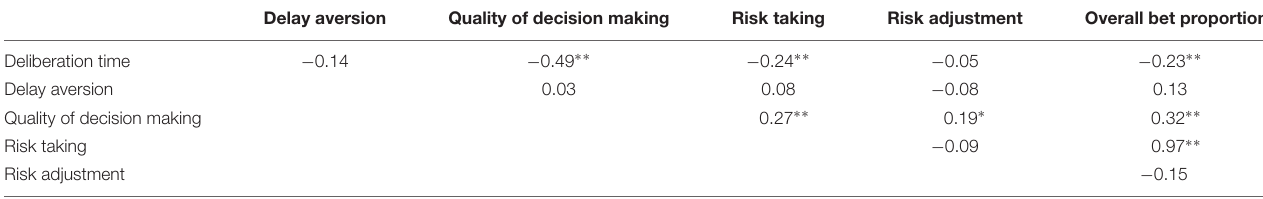
TABLE 8 | Correlations among CGT variables.